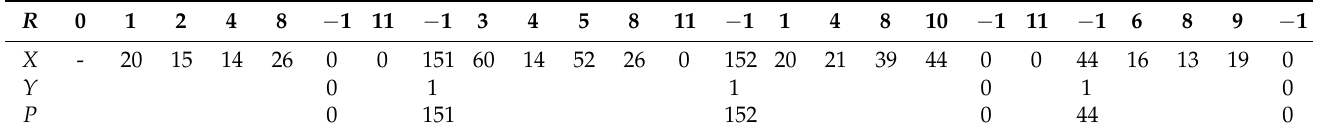
Table 7. Correction for i = 3 in C .